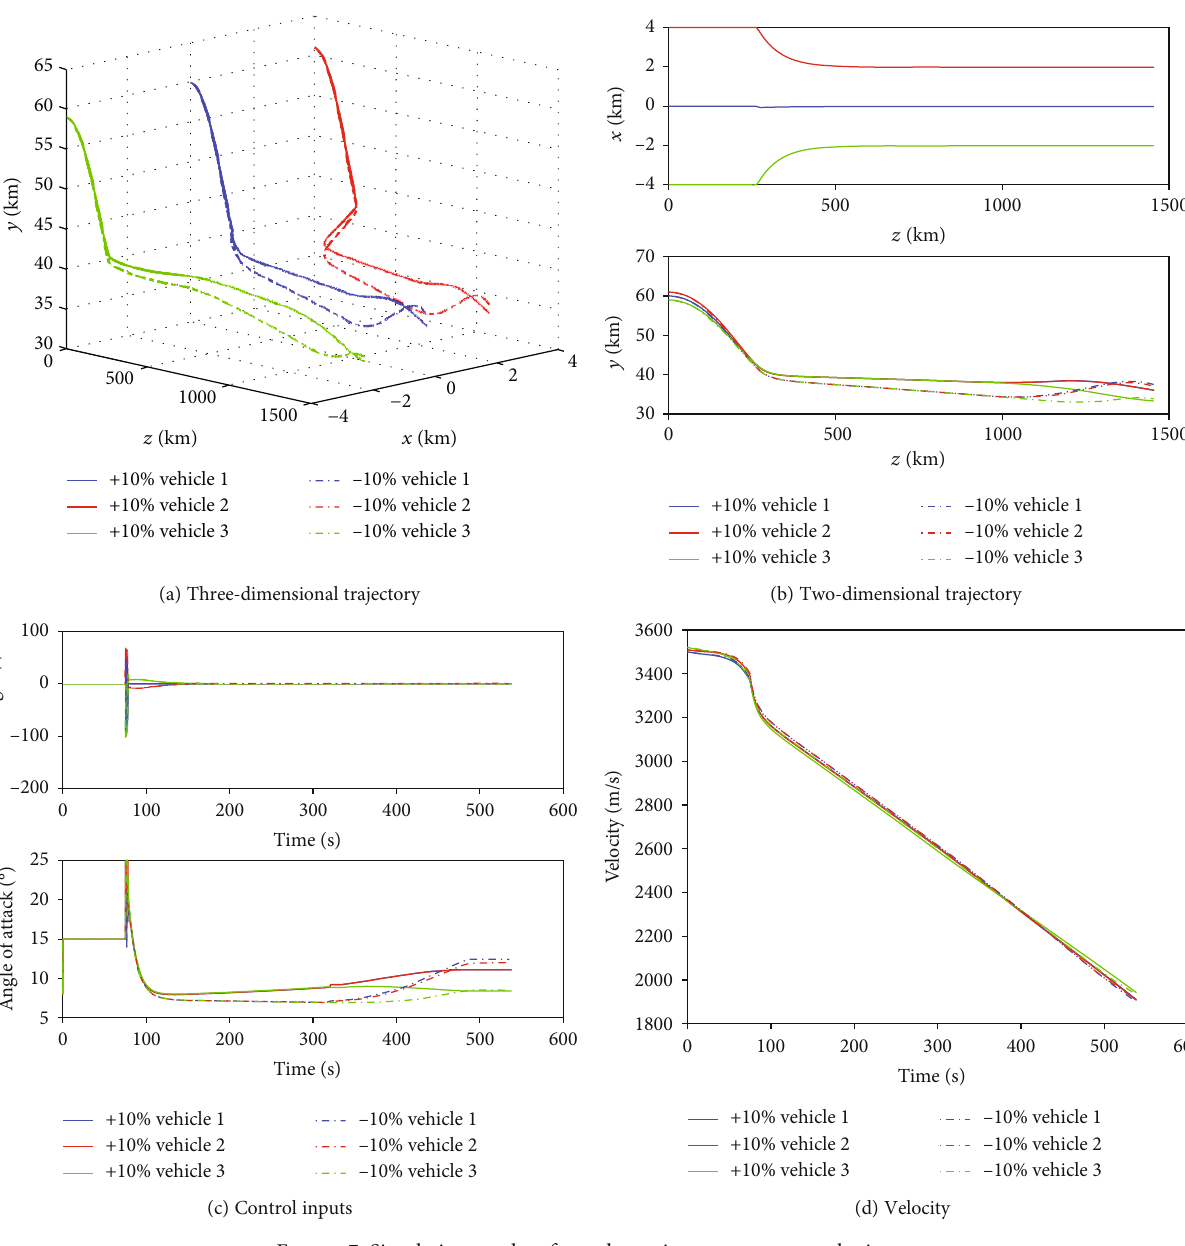
Figure 7: Simulation results of aerodynamic parameter